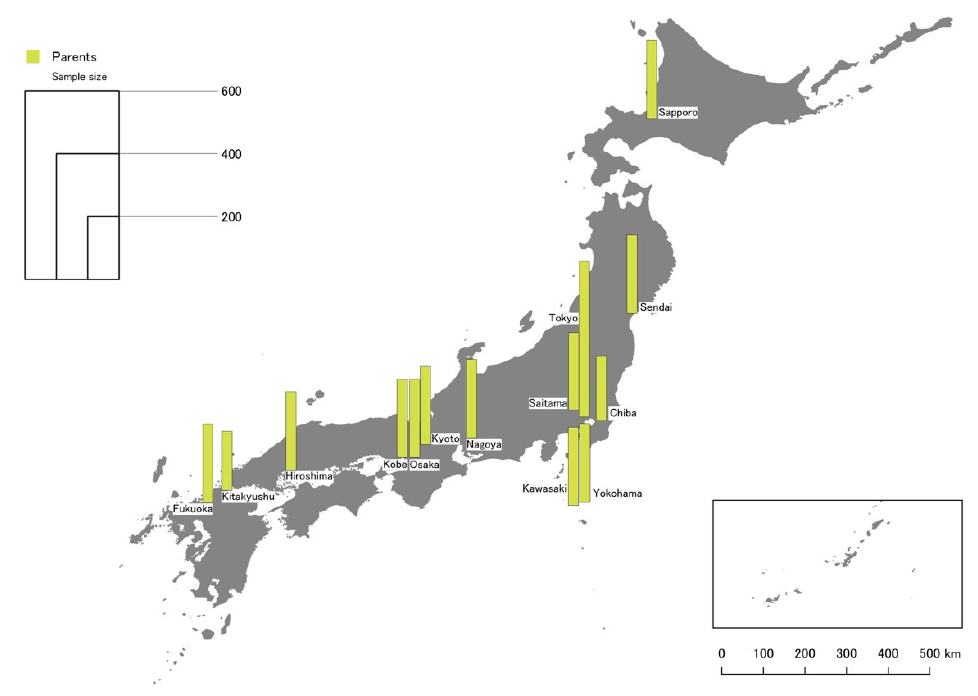
Figure 3. Study site location and samples for the parent survey.